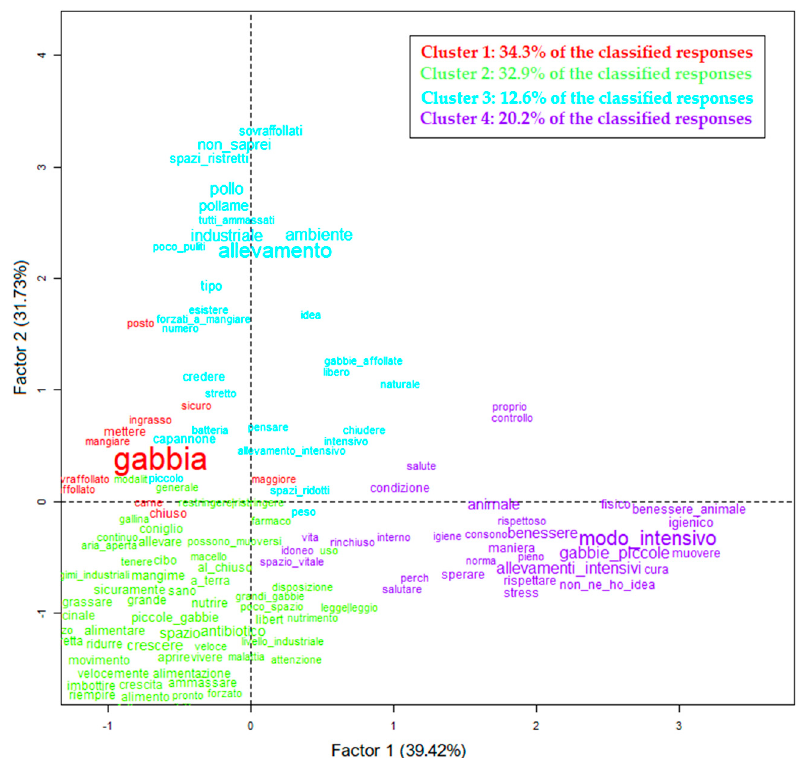
Figure 5. How do you think rabbits are raised on industrial farms? Write a short description below ( n = 499). Projection of the four clusters identified (Reinert method) on the Cartesian plane. Each color represents a cluster. The size of the words is proportional to the association score (chi-square index) with the corresponding cluster. The translation of words is available in Appendix A, Figure A1.